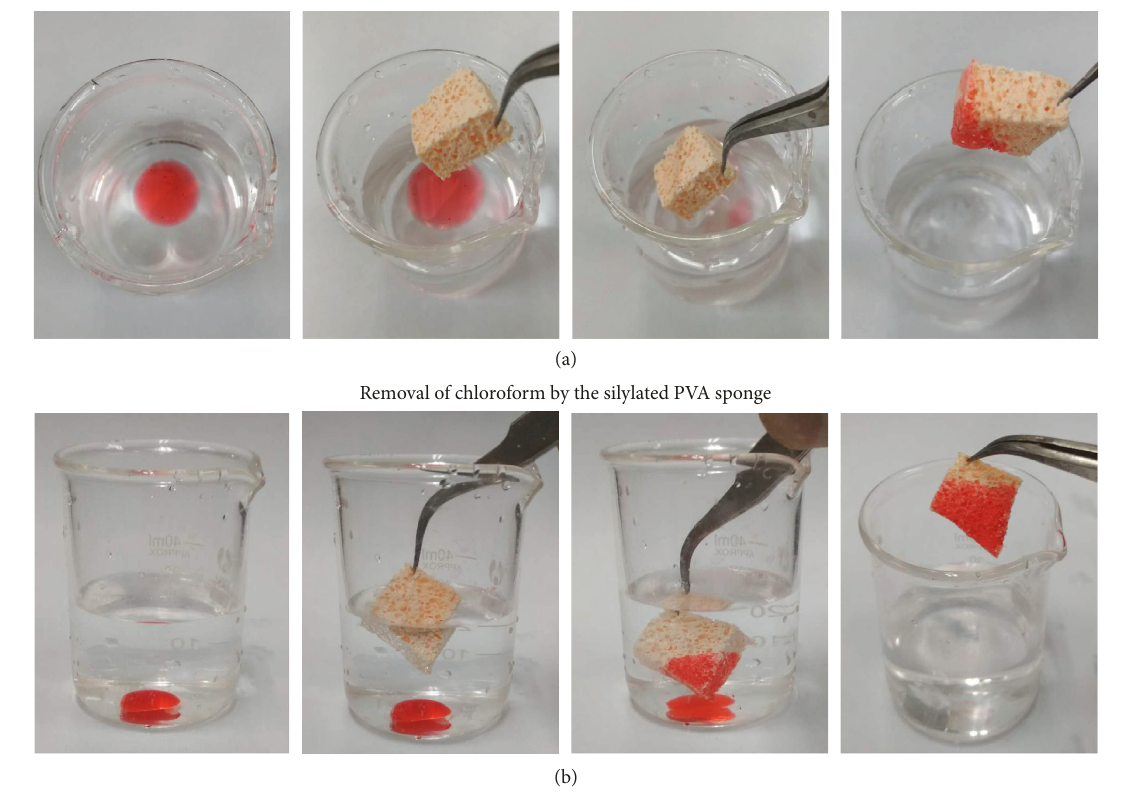
Figure 7: Selected removal of gasoline (a) and chloroform (b) from water with the silylated PVA sponge. Gasoline and chloroform are colored red with Sudan III in